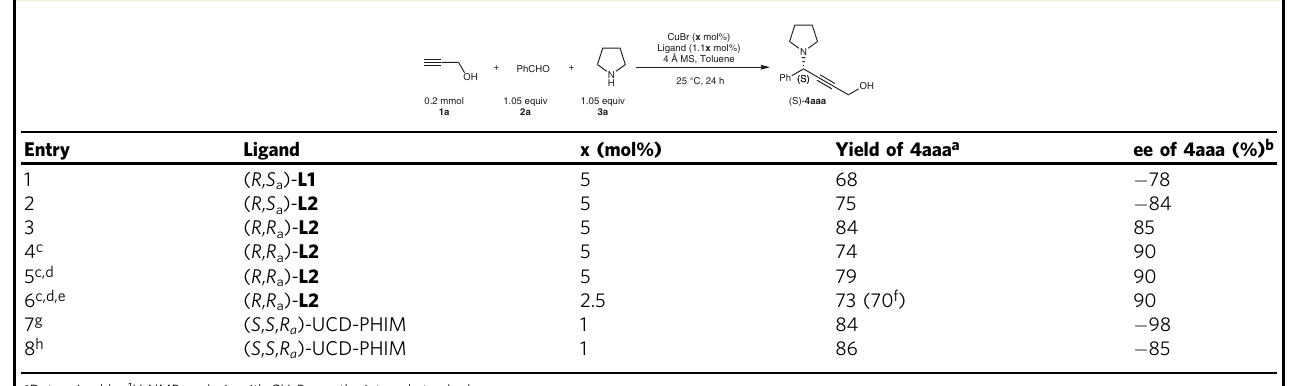
a Determined by 1 H NMR analysis with CH 2 Br 2 as the internal standard. b Determined by chiral HPLC analysis of the isolated product. c The reaction was carried out at 0°C. d 1.2 equivalents of 2a and 3a were used. e The reaction was conducted on 0.5mmol